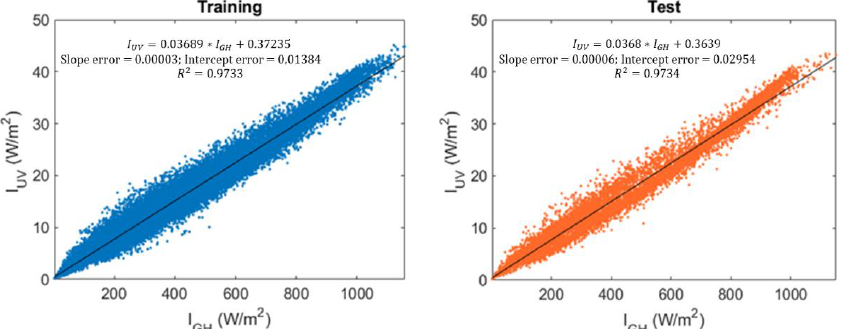
Figure 4. Ultraviolet irradiance, I UV, vs. global horizontal irradiance, I GH .